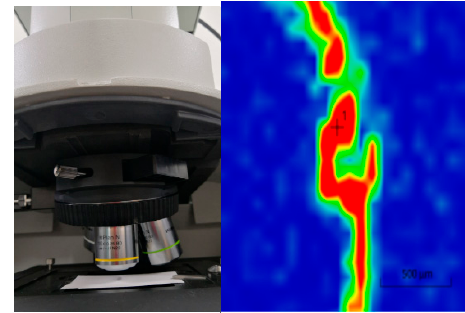
Figure 2. The detailed process of spot concentration on TLC plate ( I ), and micro-Raman imaging map ( II ).